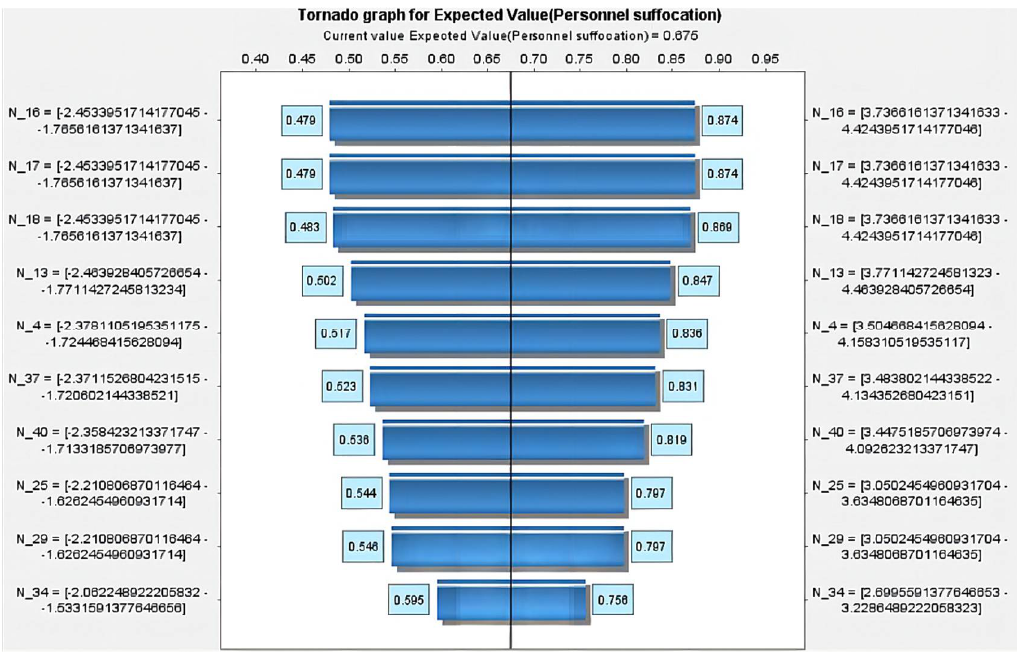
Figure 7. Sensitivity analysis for the root nodes.